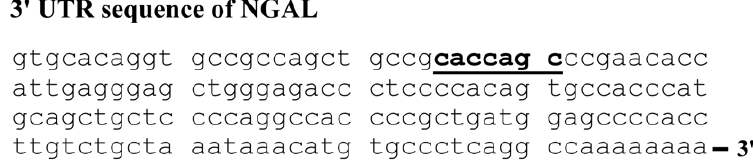
Figure 1. miR-138 target sequence identified in the 3 9 UTR sequence of NGAL. Cross-matching results from four different miRNA target identification websites revealed the miR-138 target sequence (shown in bold, underlined) in the 3 9 UTR sequence of NGAL.